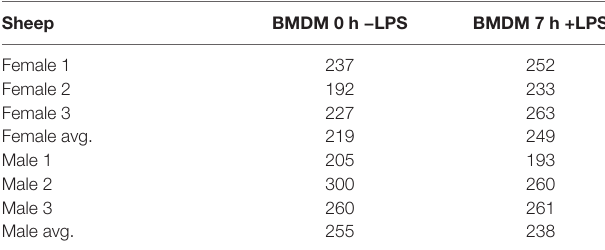
TABLE 2 | Total number of genes with significant static ASE in BMDMs ± LPS.